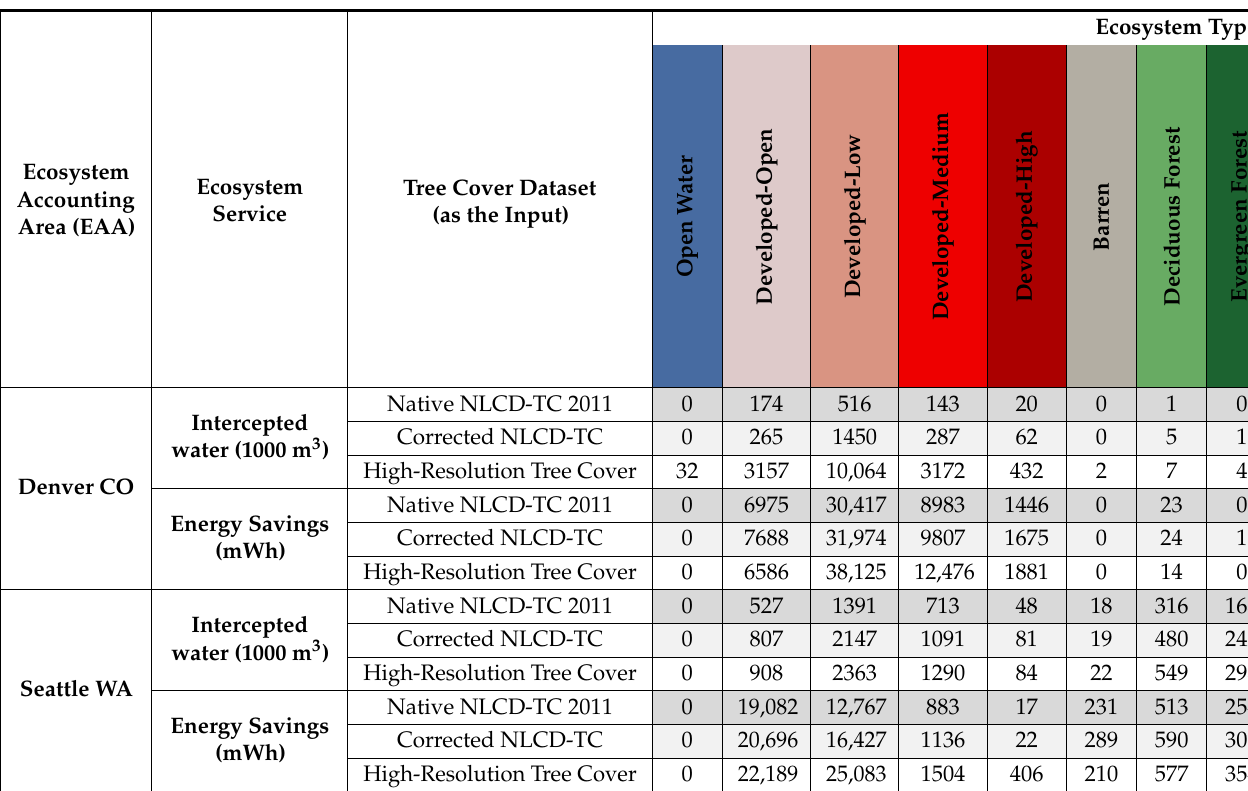
Table 4. The results of urban ecosystem accounting models for Denver and Seattle using National Land Cover Database-Tree Canopy (NLCD-TC) 2011, high- resolution tree cover data, and the corrected